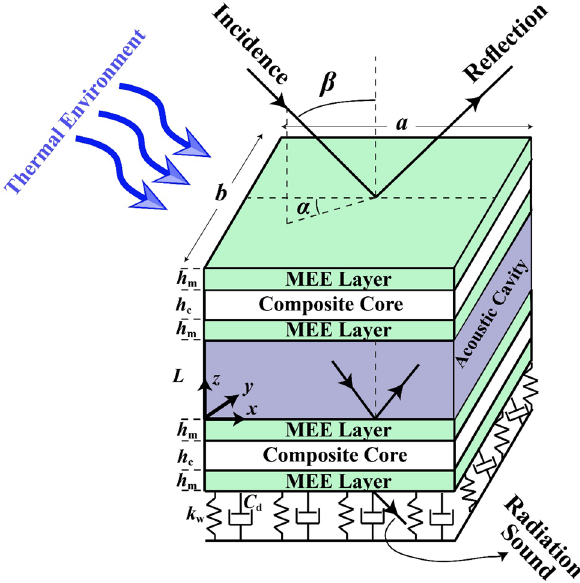
Figure 1. Configuration of double-walled sandwich composite MEE plate resting on viscoelastic medium under incidence wave and thermal